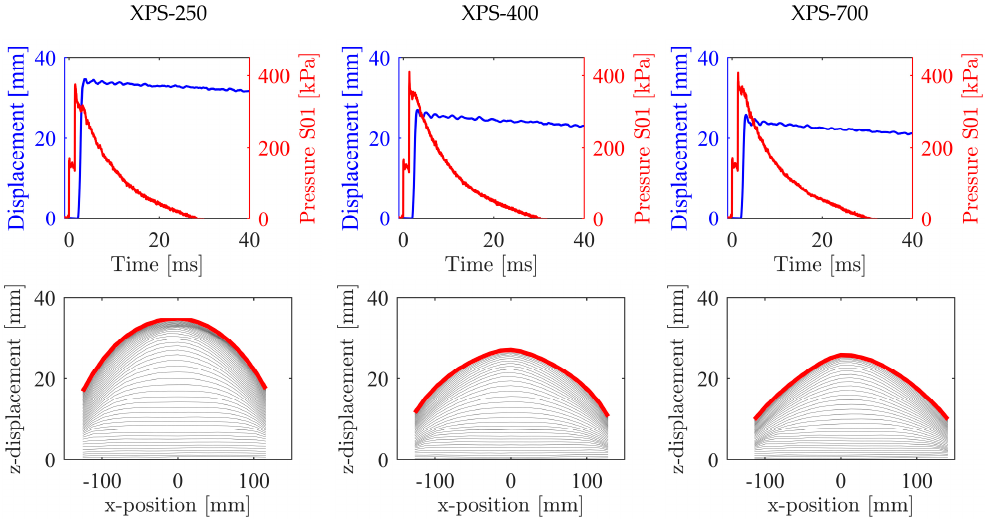
Figure 10. Displacement and pressure versus time (top) and displacement profiles (bottom) for tests on sandwich panels with 10 bar firing pressure.